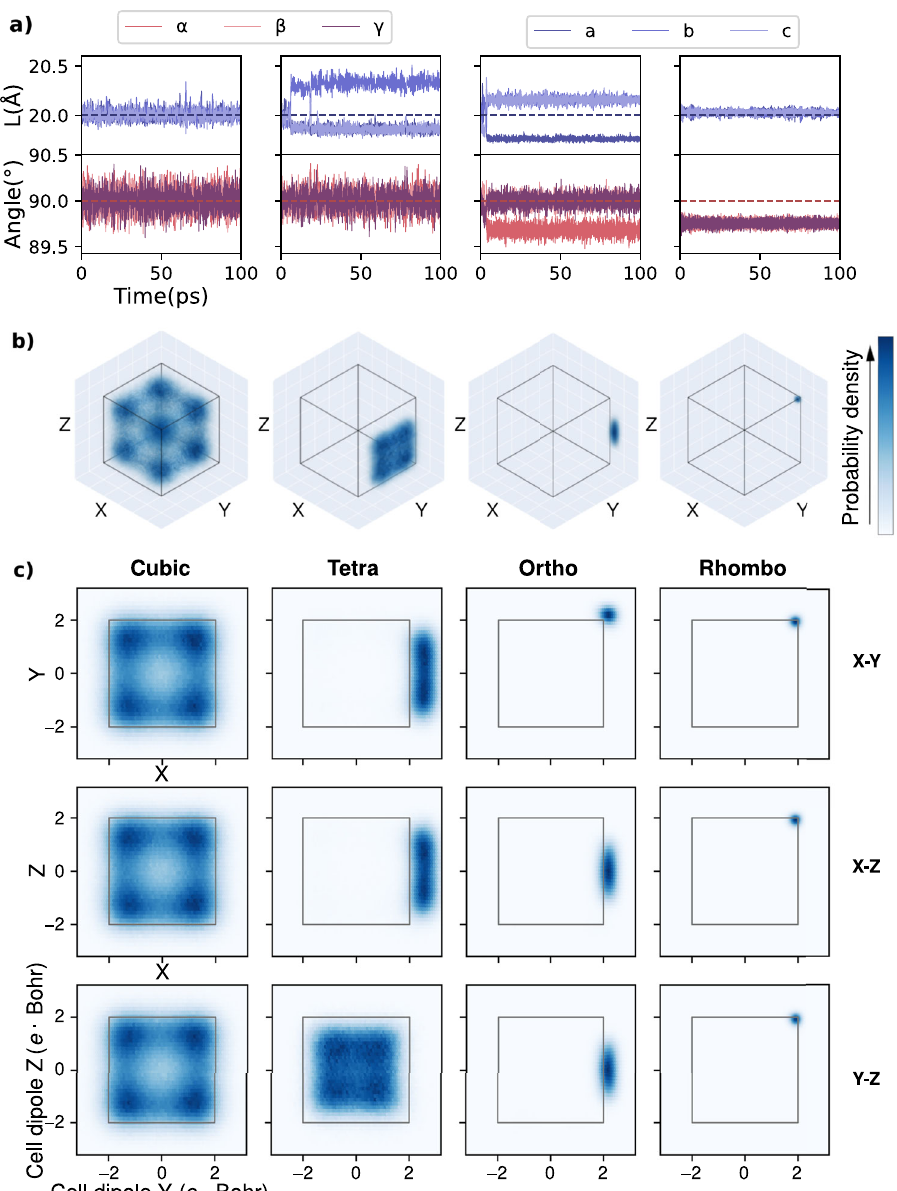
Fig. 1 The four phases of BaTiO 3 . a Time evolution of the lattice vector lengths ( a , b , and c ) and angles ( α , β , γ ) over fully fl exible MD simulations at (from left to right) 250, 100, 50 and 15K; b 3D histograms of the unit-cell polarization predicted by the SA-GPR polarization model, computed across the same simulations; c projections of those 3D histograms onto the three principal Cartesian planes (X-Y, X-Z, and Y-Z). The light gray boxes mark the range ±2 e for easier comparison between the phases. The structure of the high-frequency (dark blue) regions characterizes the different phases of BaTiO 3 , while the phase transitions are marked by a clear symmetry-breaking pattern that restricts the cell dipole to visit only a subset of the available off-centered by a clear breaking of re fl ection symmetry of the cell dipoles Figure 1 shows that the high-temperature cubic phase consists across one Cartesian (X-Y, Y-Z, or X-Z) plane. The polarization of a collection of local minima arranged at the vertices of a cube, vector can only visit four of the eight available cubic sites, marking as proposed by the eight-site model 5,13,83,84 . The presence of large the onset of the tetragonal phase. Any further decrease in the thermal fl uctuations, as compared to the energy barriers separat- temperature further reduces the symmetry of the polarization ing the minima, allows for diffusion of the polarization vector histograms by successive freezing of the polarization components across the minima over a timescale of the order of a few ps in the along a speci fi c axis. At 50 K, the polarization densities show a MD trajectories. This makes the eight local Ti minima equally single and broad minimum corresponding to an orthorhombic probable, yielding 〈 P 〉 = 0. state, while at 15 K fi nally, the system is completely frozen in one A reduction of the temperature results in a structural fi rst-order minimum corresponding to the rhombohedral state. Note that phase transition, both in agreement with ref. 26 and with previous each of the 6 tetragonal, 12 orthorhombic, and 8 rhombohedral experimental 85 and theoretical works 22,86 showing a divergence of minima that are trivially equivalent by symmetry can be reached the latent heat at the Curie point. Such transition is characterized